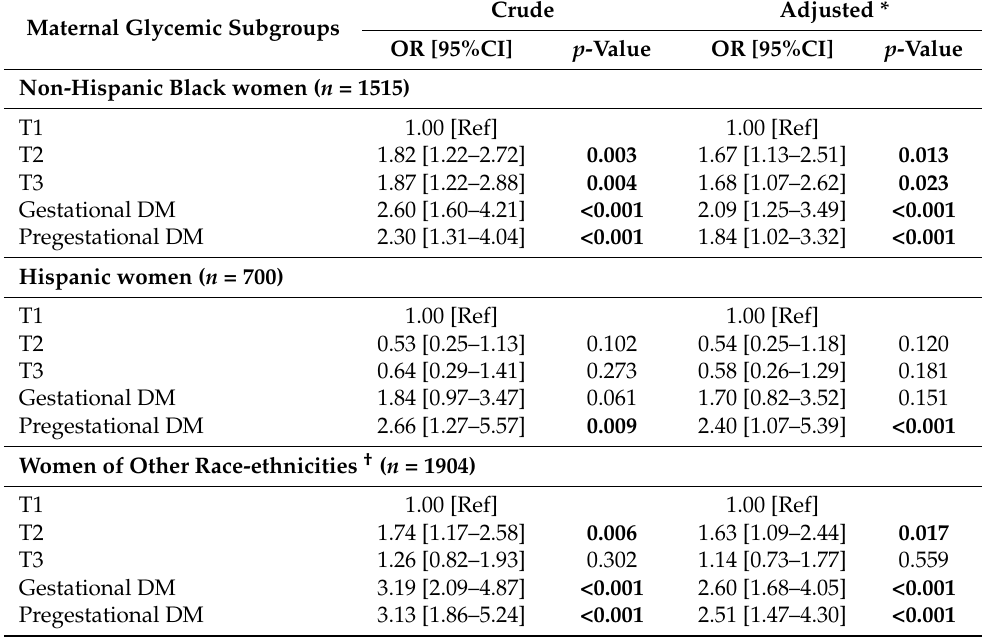
Table 3. Crude and Adjusted Odds Ratios with 95%CI for the Association of Maternal Glycemic Subgroups with Hypertensive Disorders of Pregnancy among NHB, Hispanic, and Women of Other Race-ethnicity